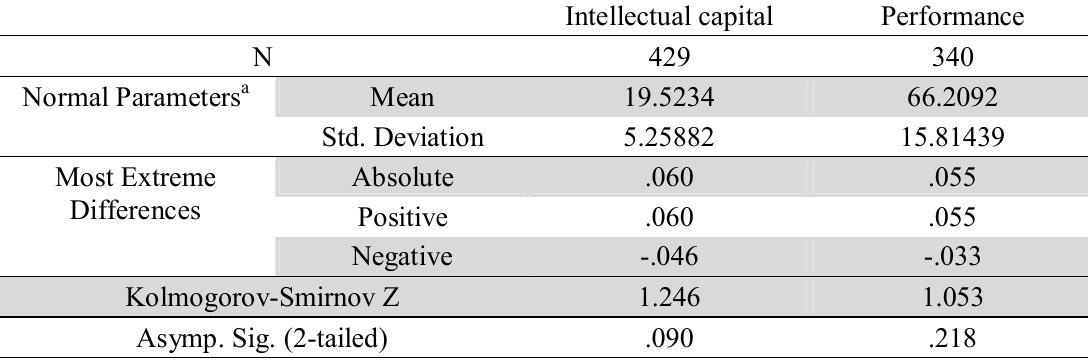
The results of Kolmogorov-Smirnov